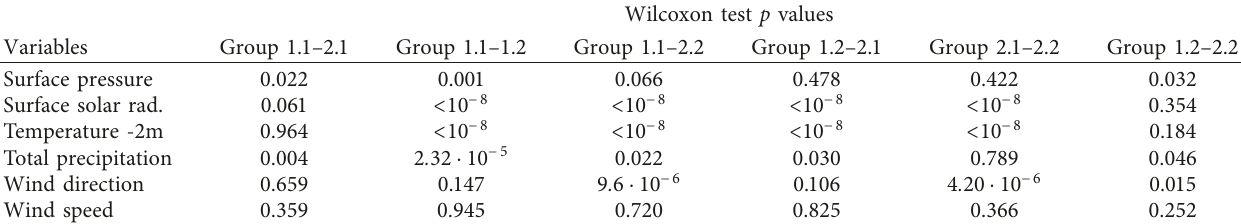
Table 2: Complete results of statistical tests comparing average values of the meteorological variables in different